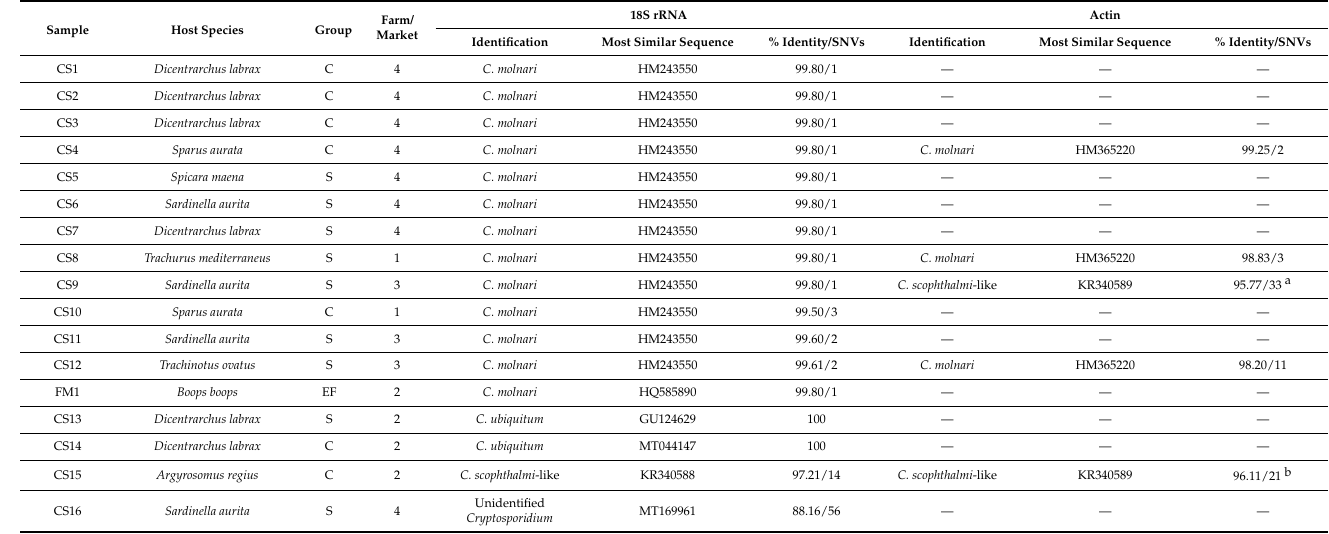
Table 3. Cryptosporidium spp. identified in marine fish at the 18S rRNA and actin genes.